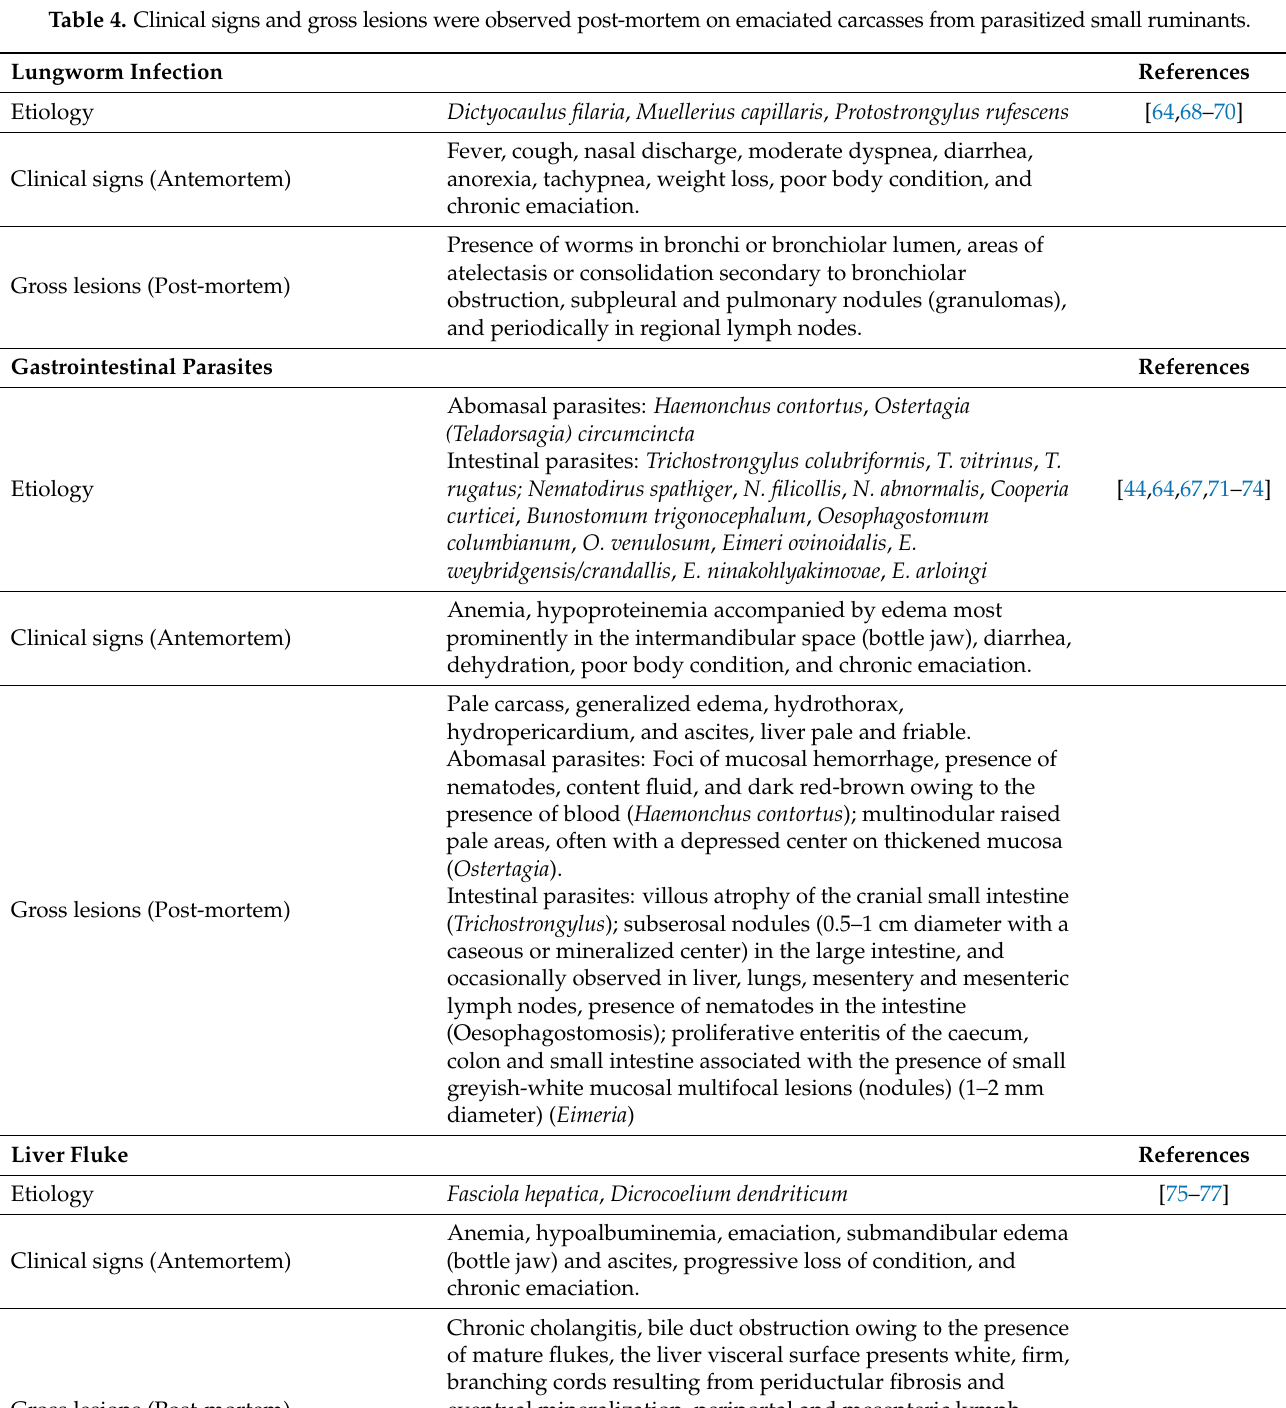
Table 4. Clinical signs and gross lesions were observed post-mortem on emaciated carcasses from parasitized small ruminants. Lungworm